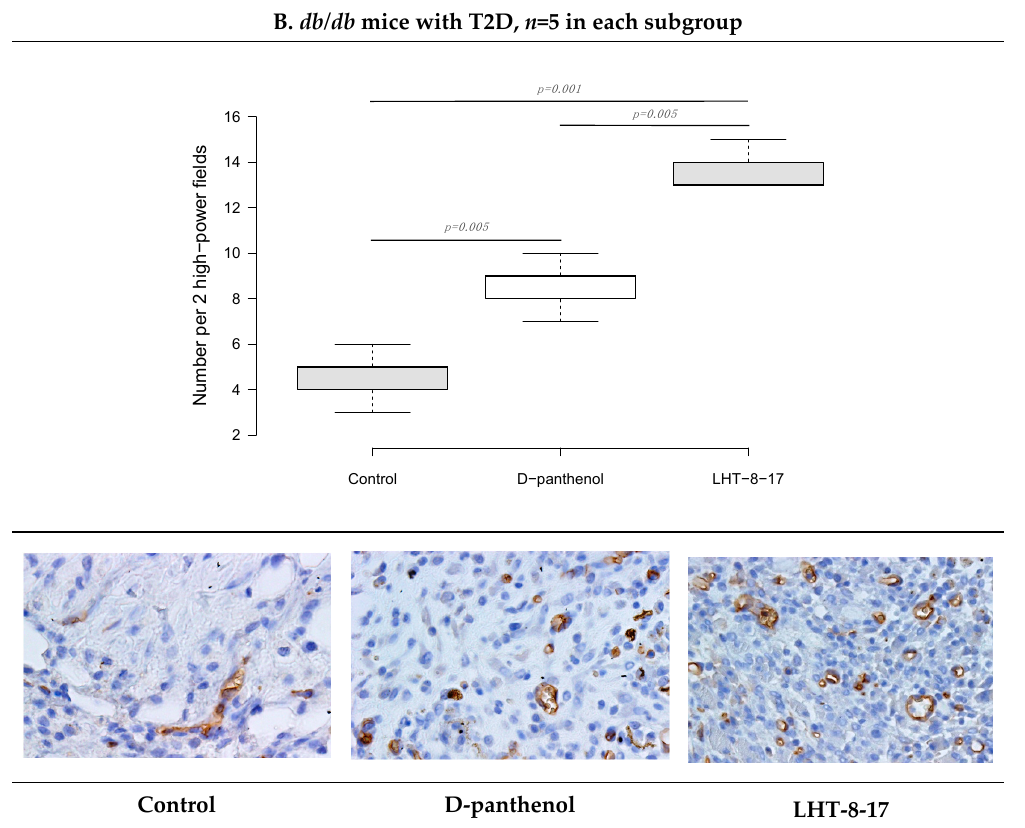
Figure 7. Vascular density and CD34+ expression status in wound tissues of animals with T1D and T2D topically treated with 4 mg LHT-8-17 twice daily, on day 10 of the observation: ( A , B )—T1D and T2D models; micro-vessel number per specimen is presented as the median ± SD, significance of differences was estimated using ANOVA and the Tukey criterion; wound tissue sections stained by rabbit monoclonal anti-CD34 antibody, IHC, 400 ×